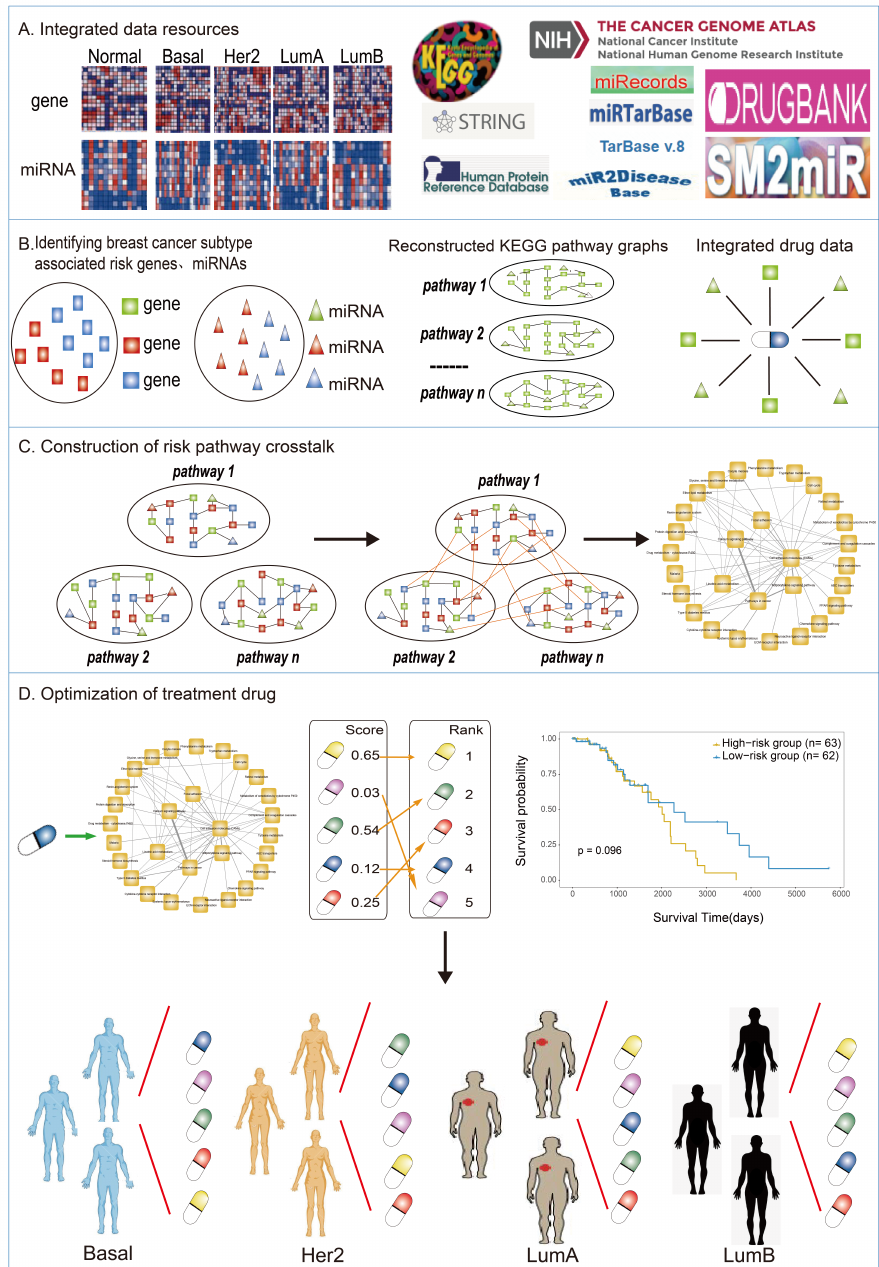
Figure 1. The workflow of optimizing drugs for di ff erent subtypes of breast cancer. ( A ) In this work, breast cancer was taken as the research model. Firstly, we integrated related data resources, including gene / miRNA expression profile of each breast cancer subtype and matching patients’ survival information, miRNA-target relationship data, PPI network and pathway data, and drug and drug target data. ( B ) We identified the di ff erential genes / miRNAs of each breast cancer subtype, and then reconstructed KEGG pathway based on miRNA-target interactions, which contained both genes and miRNAs. We also screened the target genes and target miRNAs of Food and Drug Administration (FDA)-approved anticancer drugs. ( C ) Identification of breast cancer subtype-associated risk pathways based on the di ff erential genes / miRNAs, and calculated crosstalk for any two interrelated risk pathways. Furthermore we constructed miRNA-mediated specific pathway crosstalk networks in di ff erent subtypes of breast cancer, respectively. ( D ) The e ff ectiveness assessment of drugs on dysfunction crosstalk network to screen candidate drugs, combined with survival analysis to optimize drugs for each breast cancer subtype. (See Methods section for